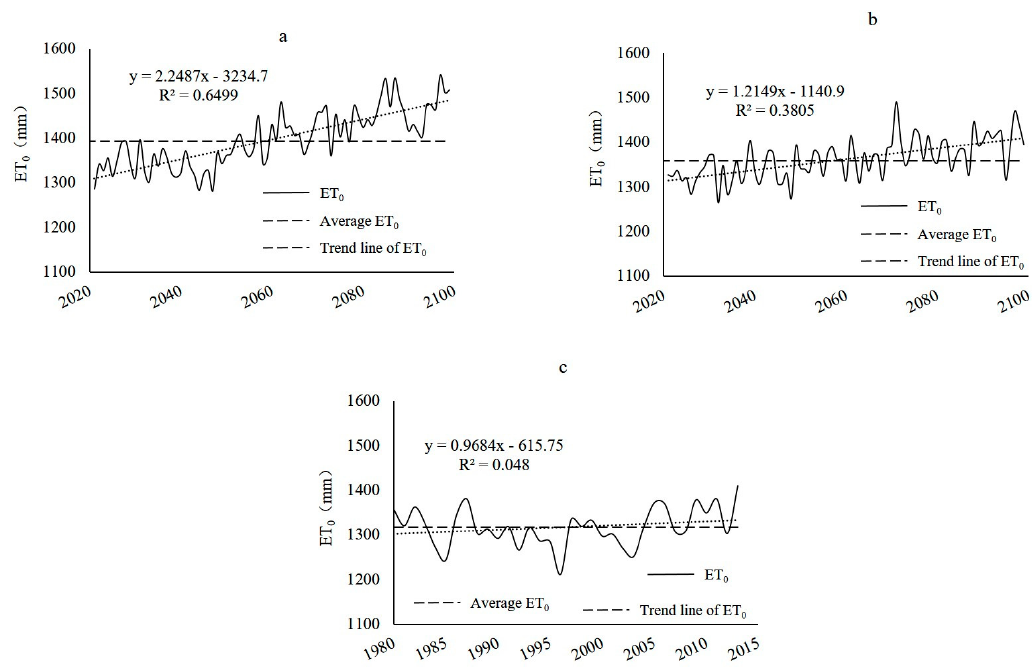
Figure 3. The temporal change of ET 0 during ( a ) 2021–2099 under scenario A2; ( b ) 2021–2099 under scenario B2; and ( c ) the present stage.